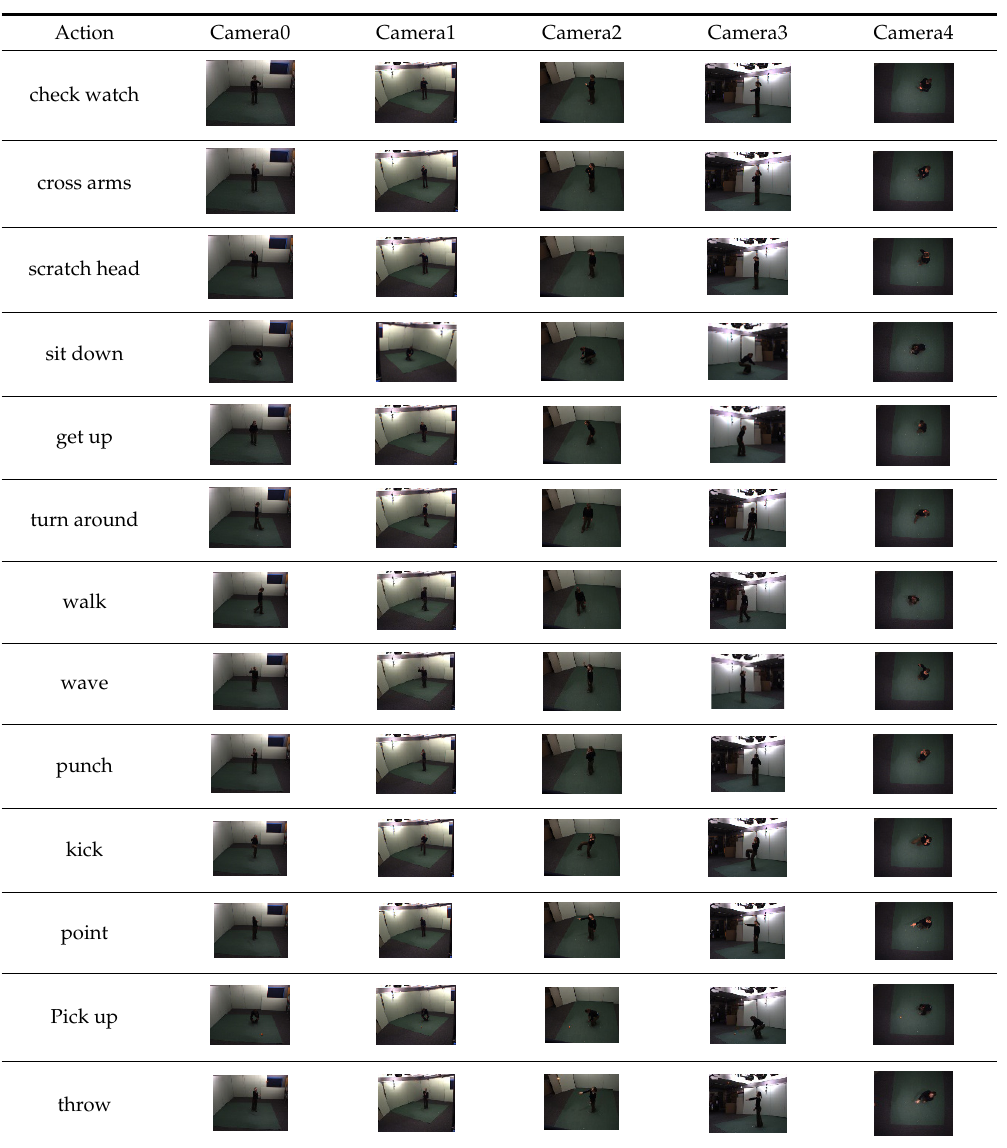
Figure 13. One frame example for each action from five different camera views in IXMAS (INRIA Xmas Motion Acquisition Sequences) dataset.